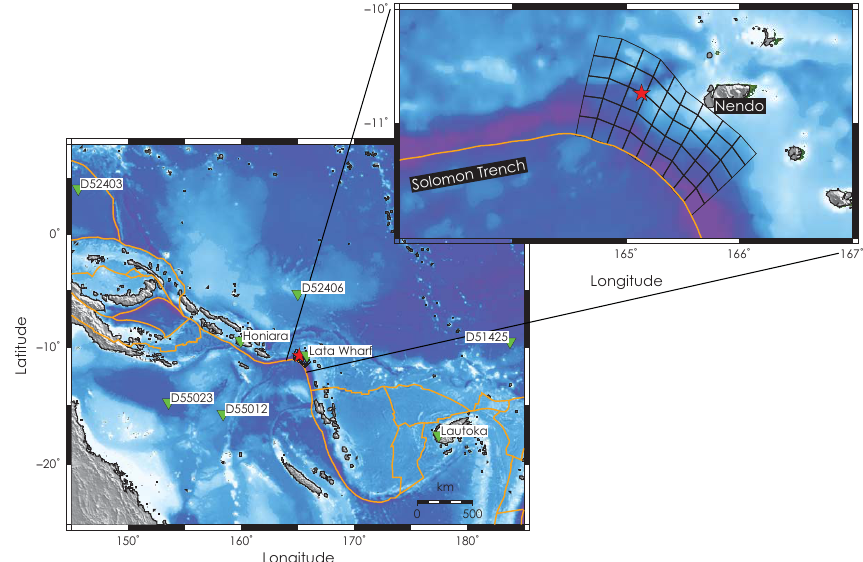
Figure 2. Data and fault model. Green triangles indicate DART buoys and tide gauges used in this study. The top-right panel is a close-up view of the fault model adopted. Red star indicates the Santa Cruz Islands earthquake